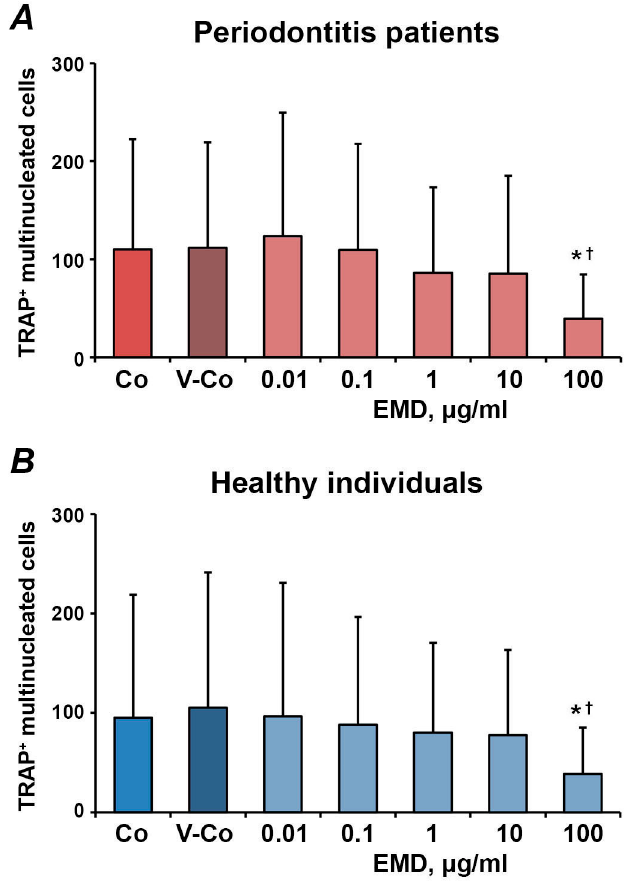
Figure 4. The effect of EMD on the formation of osteoclast-like cells from PBMCs non-adherent to pre-activated HUVECs. HUVECs were pre-activated with 25 nM TNF- α and 10 U/mL IL-1 β and co-cultured with freshly isolated PBMCs. Non-adherent PBMCs were collected and used for osteoclast-formation assay in the presence of different EMD concentrations. Cells treated with 0.01% of acetic acid were used as vehicle control (V-Co). Cells without EMD treatment were used as control (Co). Y -axis represents the number of TRAP + multinucleated cells. Data are presented as mean ± SD of 9 periodontitis patients ( A ) and 8 healthy individuals ( B ). *-significantly different compared to V-Co; †-significantly different compared to Co.